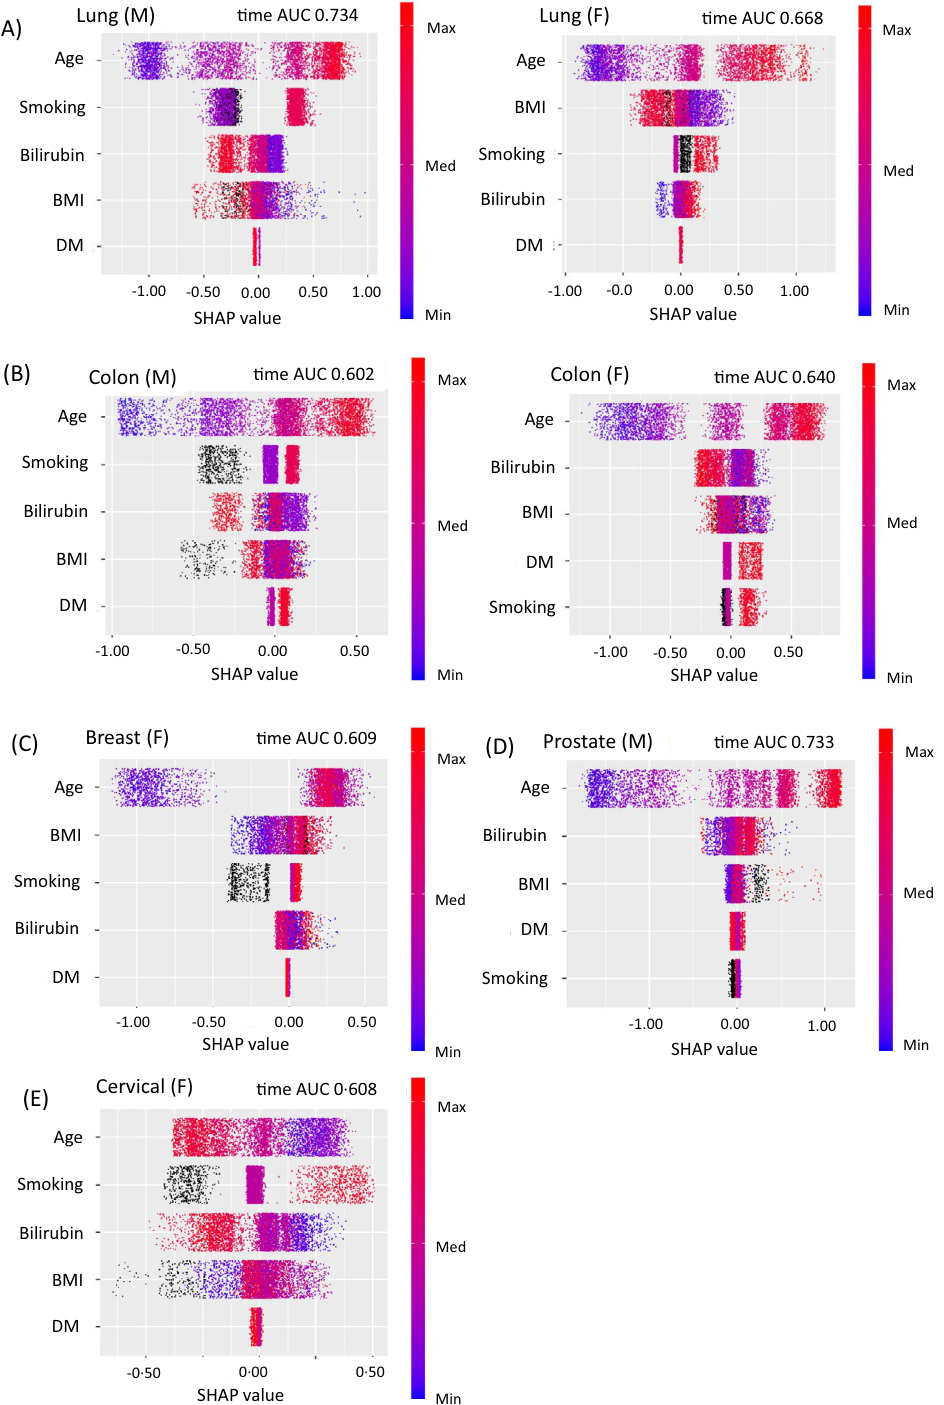
Figure 2. SHAP summary plots for cancer risk. SHAP values are shown on the x-axis and represent the contribution weight to each cancer risk in descending order. Red dot, the maximum value of a variable; blue dot, the minimum value of a variable; black dot, an unknown value of a variable. ( A ) lung cancer in men (M) and women (F), ( B ) colon cancer in men (M) and women (F), ( C ) breast cancer, ( D ) prostate cancer. ( E ) cervical cancer, ( F ) total all-cause death in men (M) and women (F). SHAP value, SHapley Additive exPlanations; Bilirubin, serum bilirubin levels; BMI, body mass index; DM, diabetes; AUC, area under the